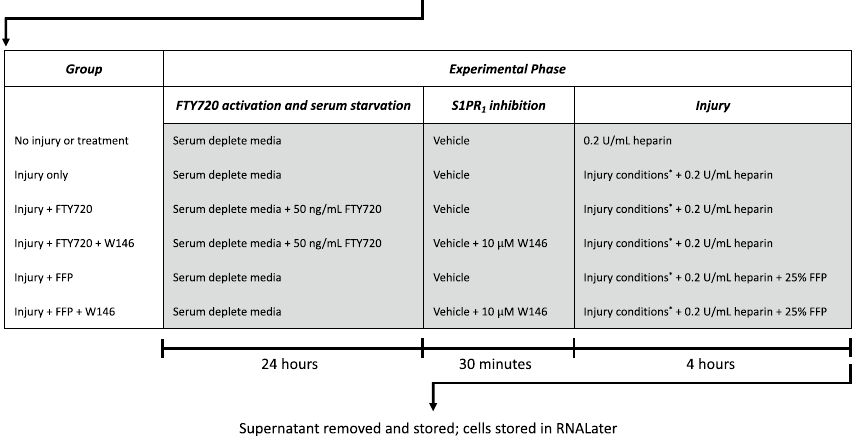
Fig. 1 Experimental protocol. Asterisk indicates injury conditions: 1.0 nM adrenaline, 10 ng/mL TNF-α, and 100 μM H2O2 in a 5% CO 2 incubator at 37